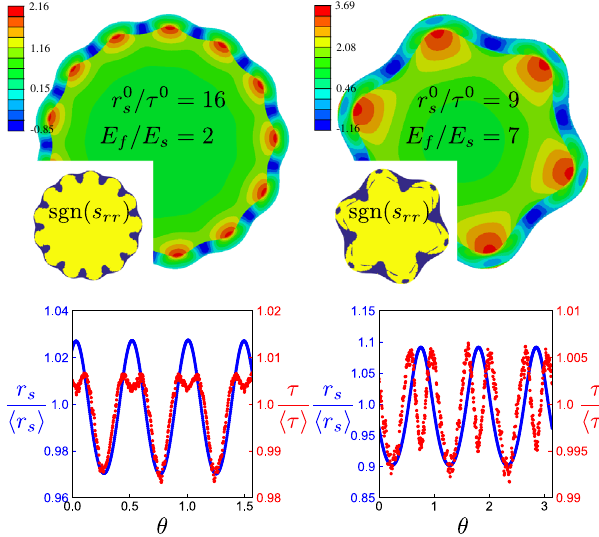
FIG. 1. Elastic bilayer wrinkling generates film thickness oscillations that are overall in phase with the substrate deforma- tion when the film is thin. Top row: maximum in-plane principal stress (normalized to half of the substrate ’ s shear modulus) for two different circular wrinkling problems. r 0 s = τ 0 is the initial substrate radius in units of the initial film thickness, and E f =E s is the stiffness contrast. Insets plot the sign of the stress-tensor component s rr , with yellow indicating positive values (tension) and purple indicating negative values (compression). Bottom row: substrate radius (blue) and film thickness (red), normalized to their average values, for the same two wrinkling problems. Note the different scales on left and right